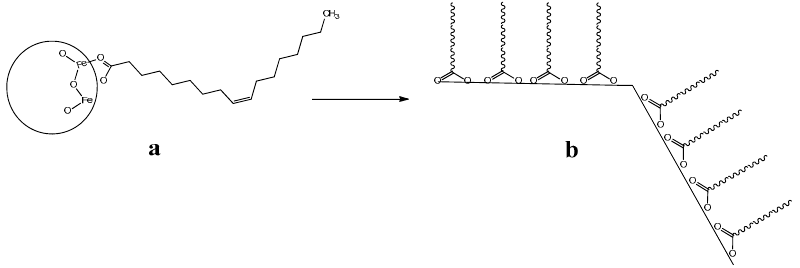
Figure 3. Scheme of the hybrid system. ( a ) Carboxylic groups are bonded unequally. ( b ) Two kinds of oleate chains: those on the facet of the iron oxide crystal and those on the edge.